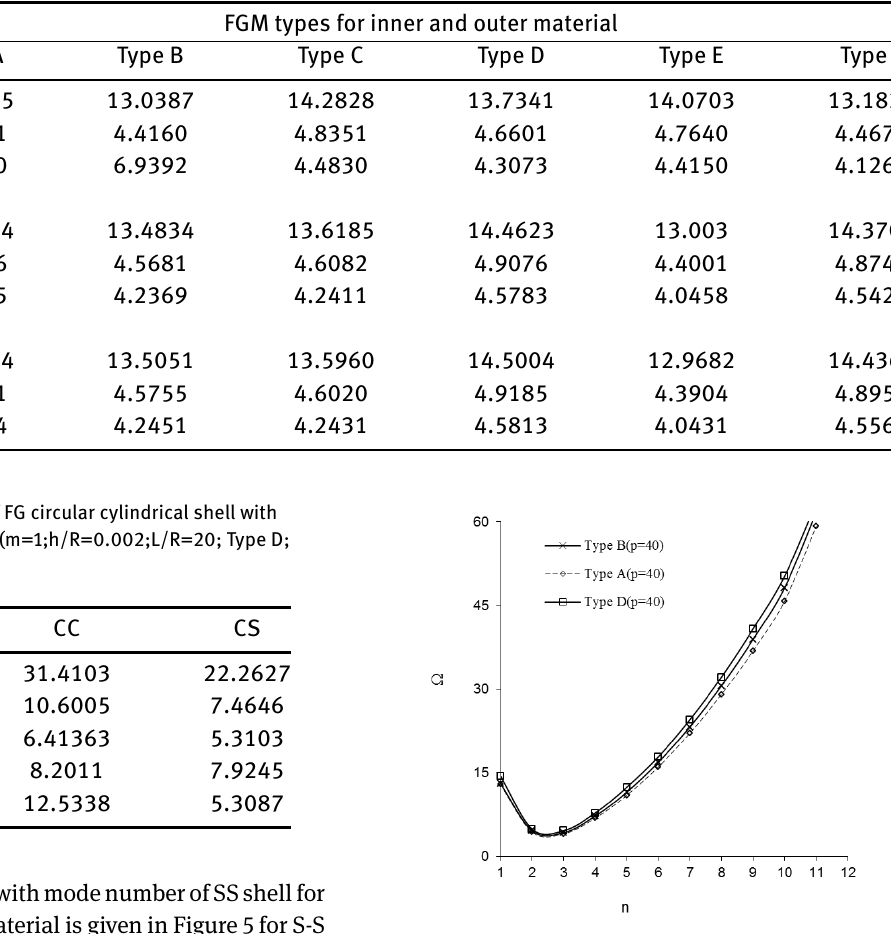
Figure 5: Variation of frequency values with mode number of SS shell for different types of FGM method is also produces more accurate results for classical single material